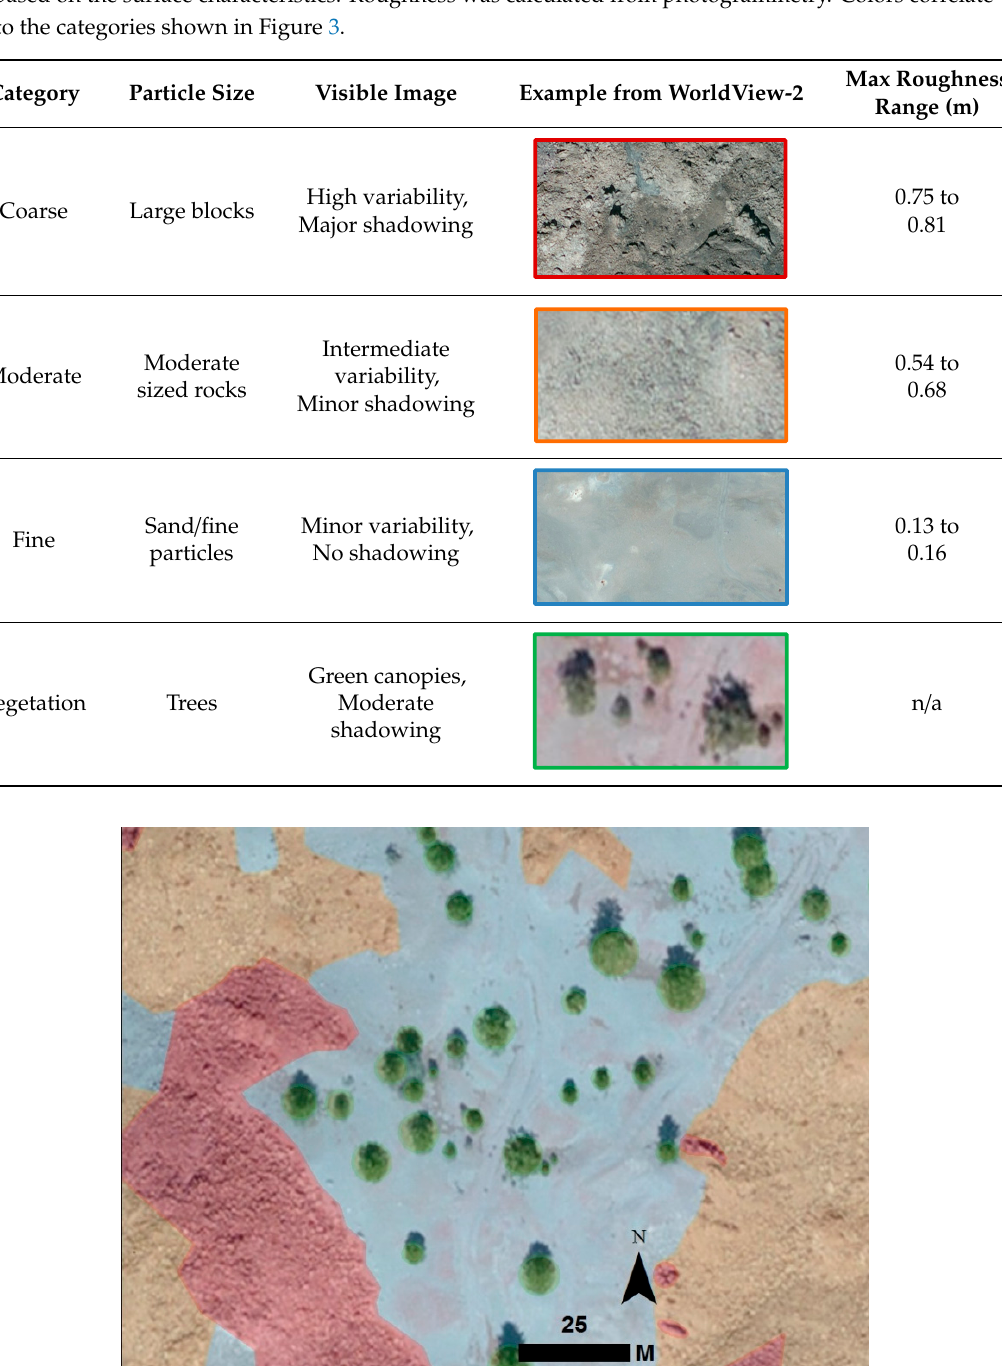
Figure 3. Examples of the four categories overlain on the visible WorldView-2 data used for this qualitative mapping. The colors of the regions correlate to the categories in Figure 2.